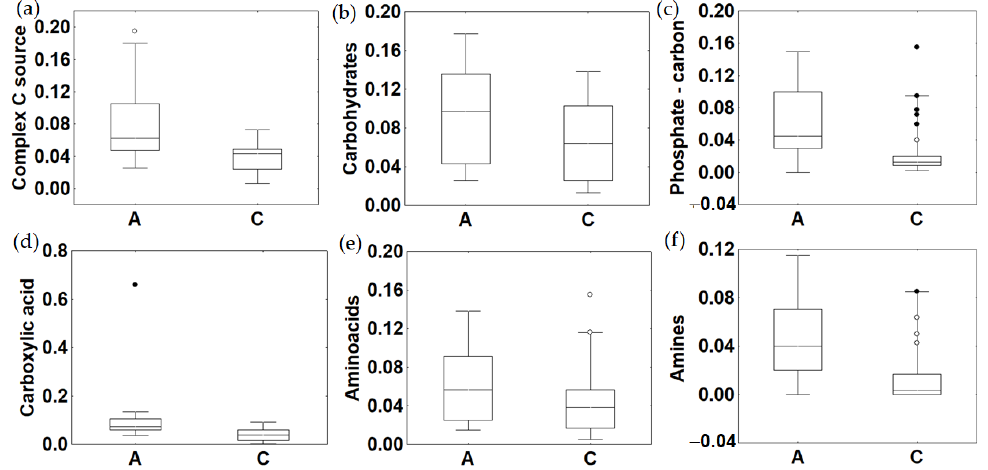
Figure 9. Box plots of the main categories of Carbon sources utilized by the microbial community, namely ( a ) complex C sources, ( b ) carbohydrates, ( c ) P-C compounds, ( d ) carboxylic acids, ( e ) amino acids and ( f ) amines. The boxes are characterized by a median line and boundaries indicating 25th and 75th percentiles; whiskers area characterized by a vertical line indicating 5th and 95th per-centiles. White dots = outliers, black dots = extreme